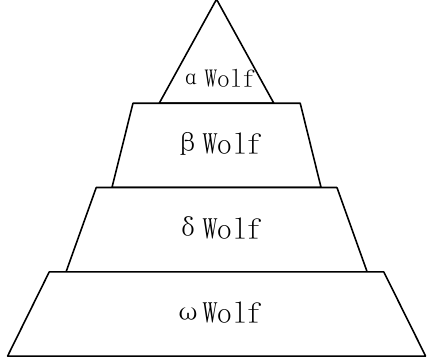
Figure 2. The division of grey wolf social hierarchy.